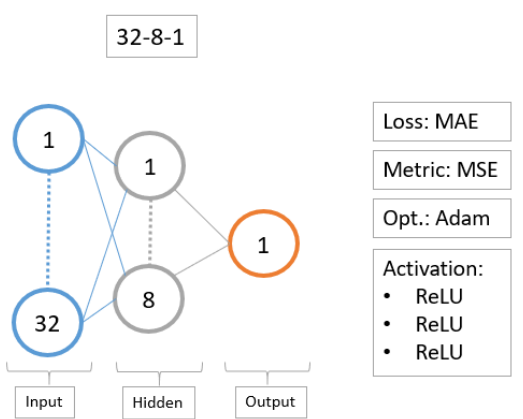
Figure 16. Selected network architecture. Source: Own elaboration.